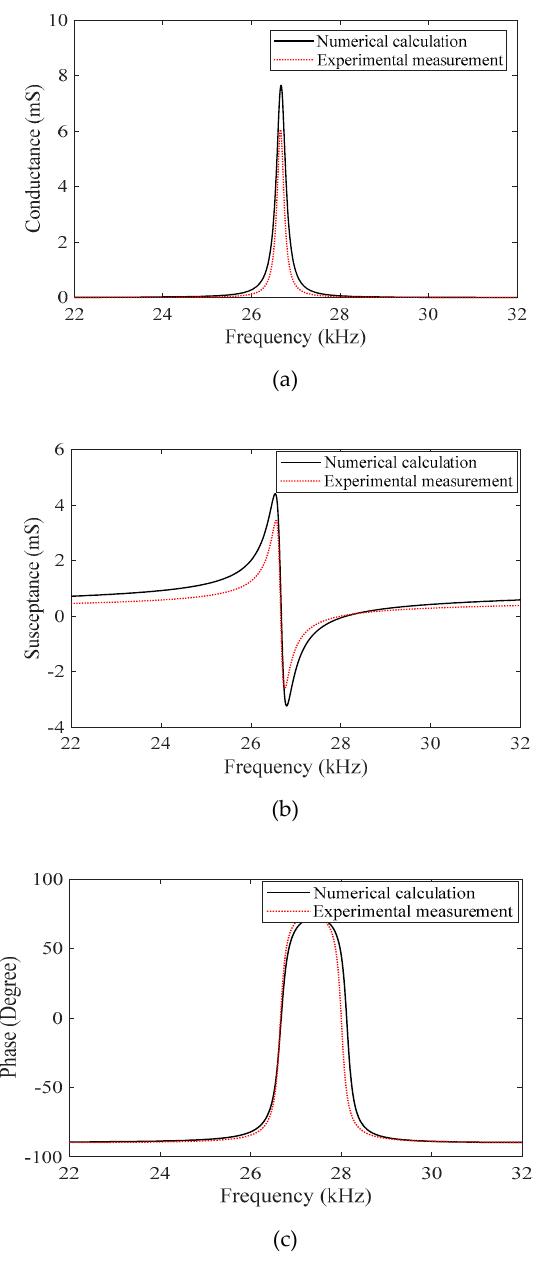
Figure 5. The impedance characteristics of the ultrasonic transducer. ( a ) Conductance; ( b ) Susceptance; ( c ) Phase.